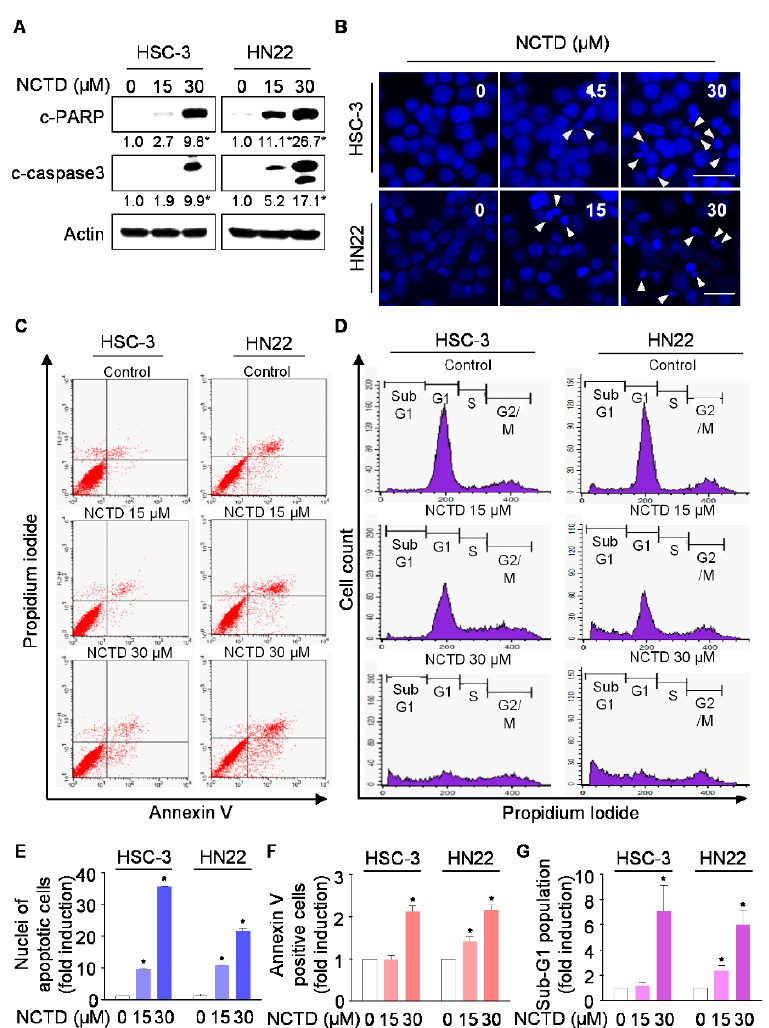
Figure 2. Effects of NCTD on programmed cell death. HSC-3 and HN22 cells were treated with DMSO or certain concentrations of NCTD for 48 h. ( A ) The cell lysates were analyzed by western blotting to detect the cleavages of caspase 3 and poly (ADP-ribose) polymerase (PARP). Data represent the mean of triplicate experiments. *, p < 0.05 is compared with the control group. ( B ) Nuclear morphology was detected by 4-6-Diamidino-2-Phenylindole (DAPI) staining, showing chromatin condensation and nuclear fragmentation (indicated by white arrows) (scale bar, 25 µ m). ( C ) Apoptotic cells were detected by the annexin V / propidium iodide (PI) double-staining. ( D ) Sub-G 1 population was analyzed by PI staining. ( E – G ) Quantifications of nuclei of apoptotic cells, annexin V-positive cells, and sub-G 1 population were calculated, respectively. Graphs represent the mean ± SD of three independent experiments, and significance compared with the control group is indicated (*).